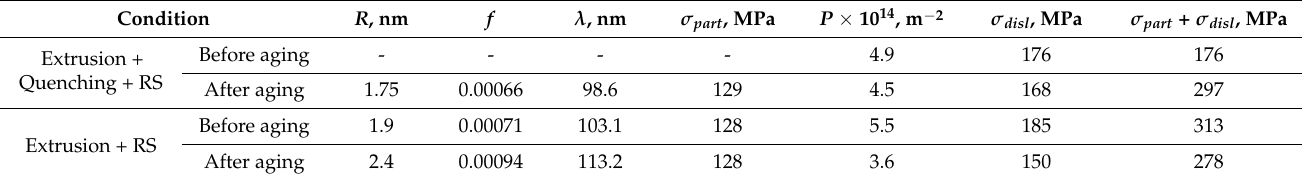
Table 2. Particle ( σ part ) and dislocation ( σ disl ) strengthening of the Cu-0.5%Cr-0.08%Zr alloy in various microstructural conditions with the size ( R ) and volume fraction ( f ) of bcc Cr particles, interparticle distance ( λ ) and dislocation density ( ρ